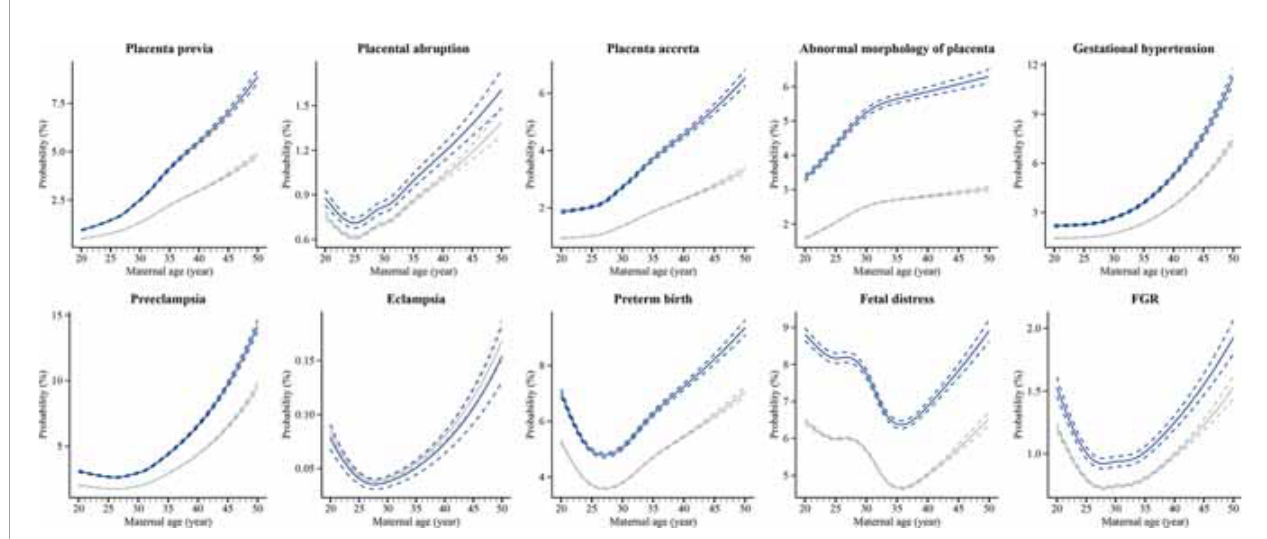
FIGURE 2 | Estimated absolute risks of placental abnormalities and placenta-related complications at each maternal age in IVF group and non-IVF group IVF, in vitro fertilization; Non-IVF, non- in vitro fertilization; FGR, fetal growth restriction. Estimated absolute risks (probabilities) were calculated by using Poisson regression modelling with restricted cubic splines of exact maternal age, with adjustment for geographic region, maternal age, year, ethnicity, and chronic diseases before pregnancy.